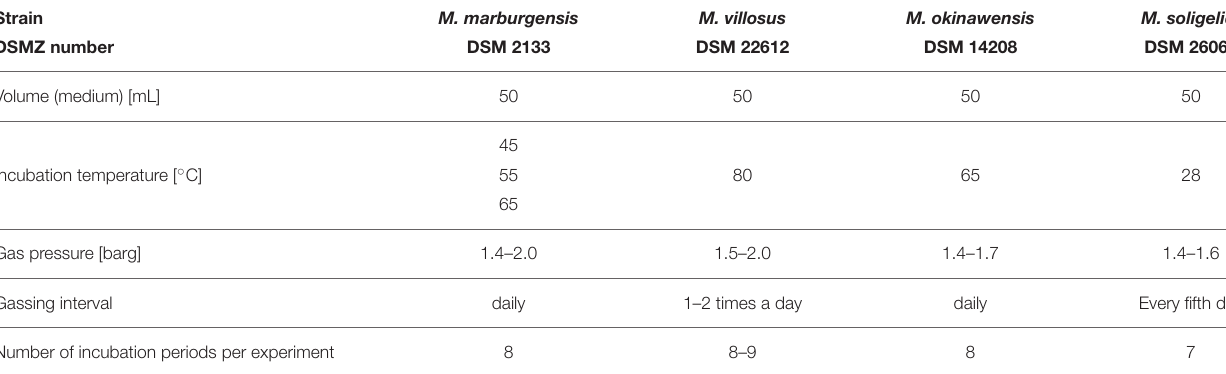
TABLE 1 | Overview of methanogens and cultivation settings used in this study.